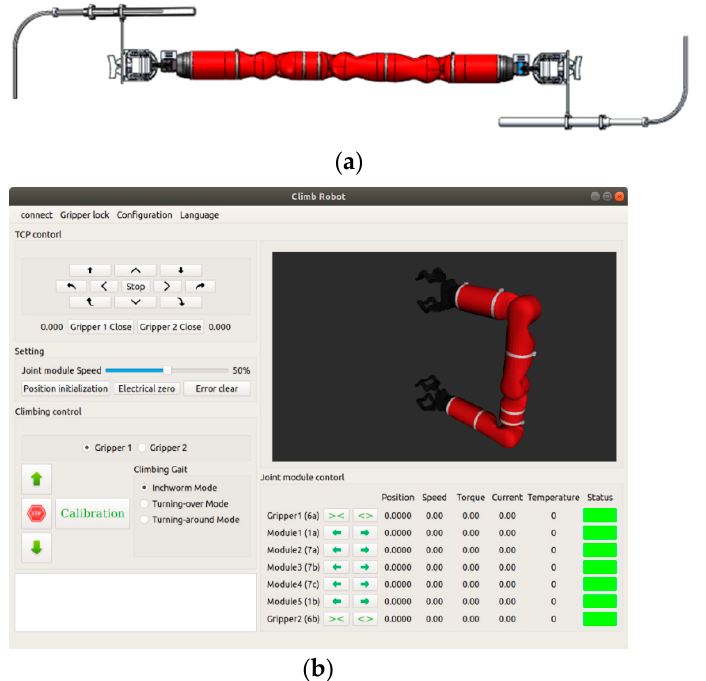
Figure 5. The biomimetic power distribution live working robot system. ( a ) Hardware system of the robot, ( b ) control interface of the robot.